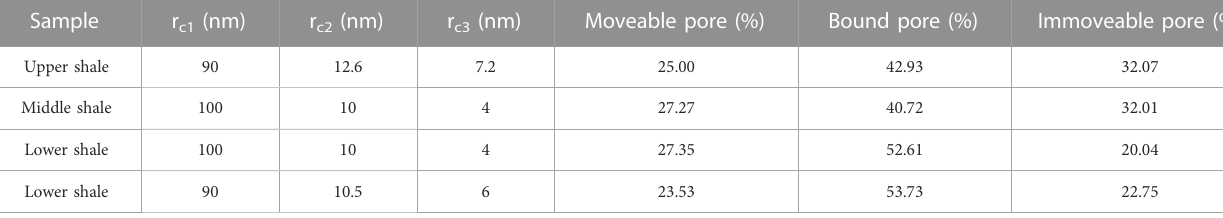
TABLE 3 Statistics of different pore types contents and lower limit of pore